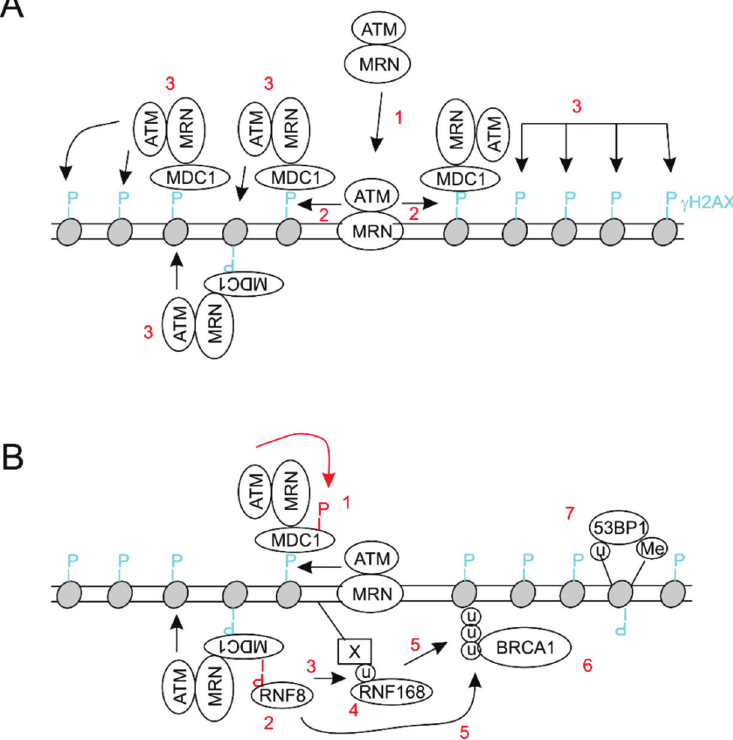
Figure 1. Schematic illustration of the assembly of the double-stranded DNA break (DSB) repair complex. ( A ) The MRN complex recruits ATM to DSB (1), allowing ATM to phosphorylate S139 of H2AX ((cid:2)H2AX) (2); and (3): MDC1 is subsequently recruited and the CK2-phosphorylated SDT motifs at the N -terminus of MDC1 interact with the MRN-ATM complex, resulting in the spread of the (cid:2)H2AX domain. ( B ) The association of the MRN-ATM complex with MDC1 leads to ATM-mediated phosphorylation of MDC1 (1), RNF8 recruitment (2), RNF8-derived ubiquitination of unknown substrate (X) (3), and the binding of RNF168 (4); and (5): RNF8 and RNF168 coordinately ubiquitinate histone H2A/H2AX, paving the way for BRCA1 recruitment (6). The ubiquitination of H2A K15 together with H4 K20 methylation contribute to 53BP1